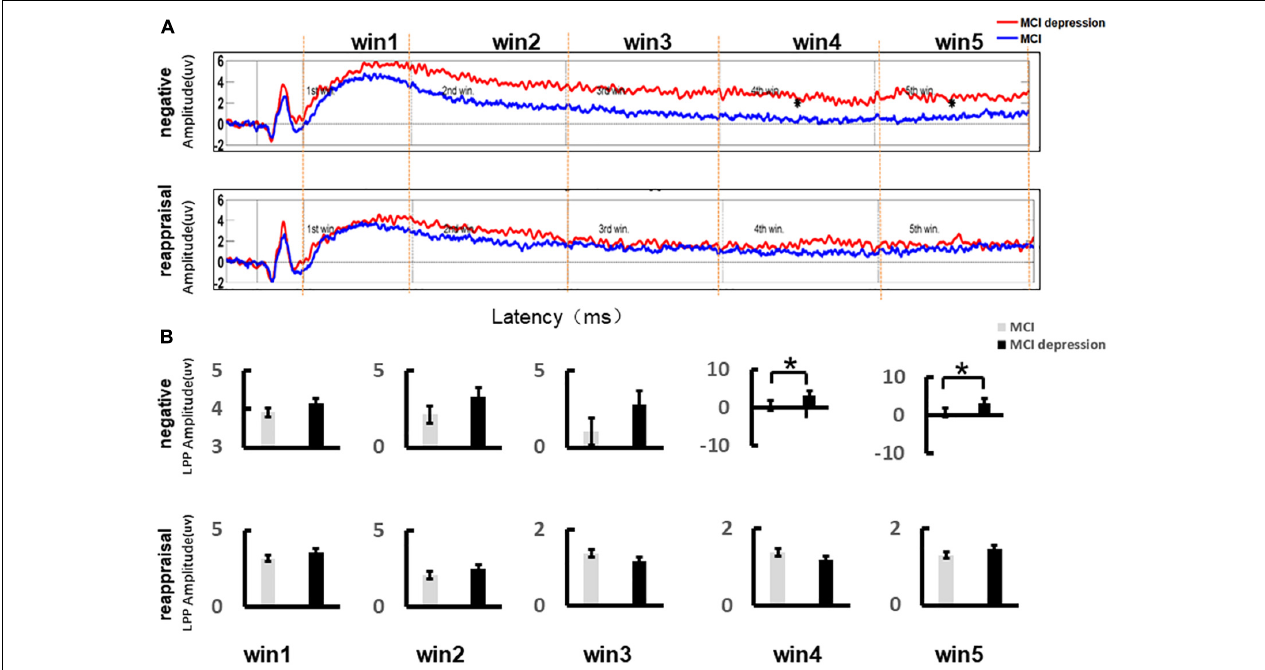
FIGURE 3 | Grand average event-related potentials and amplitude differences of the LPP during the Emotion Regulation task. (A) Illustrates the event-related potential (ERP) amplitude in the Emotion Regulation trial; the LPP time window (Win3: 2,000–3,000 ms; Win4: 3,000–4,000 ms; Win5: 4,000–5,000 ms). (B) Demonstrates the LPP amplitude difference during the Emotion Regulation task between the MCI and MCI depression group. * p <